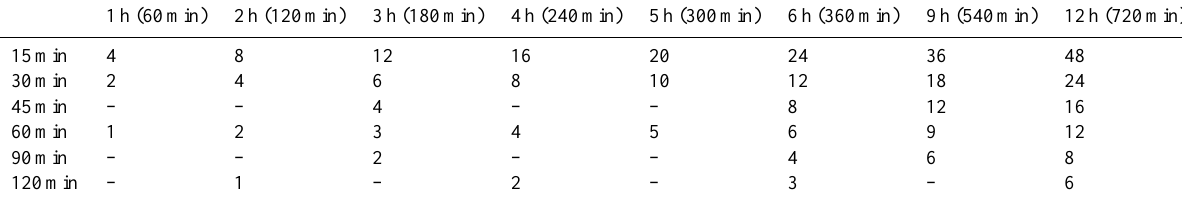
Table 6. Lead steps of the forecasting system with different time